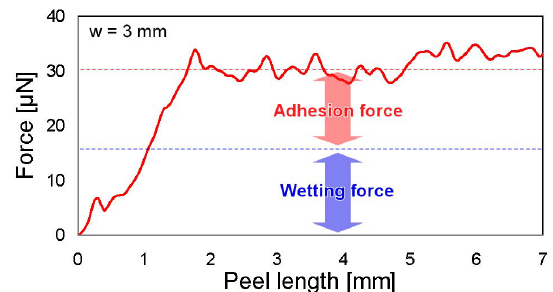
Fig. 6 An example profile of measured force. The red dotted line indicates the average of total force which was measured, and the blue dotted line indicates the average of the downward force (wetting force) which was measured previously. The adhesion force was the margin between the average of total force and the average of wetting force.